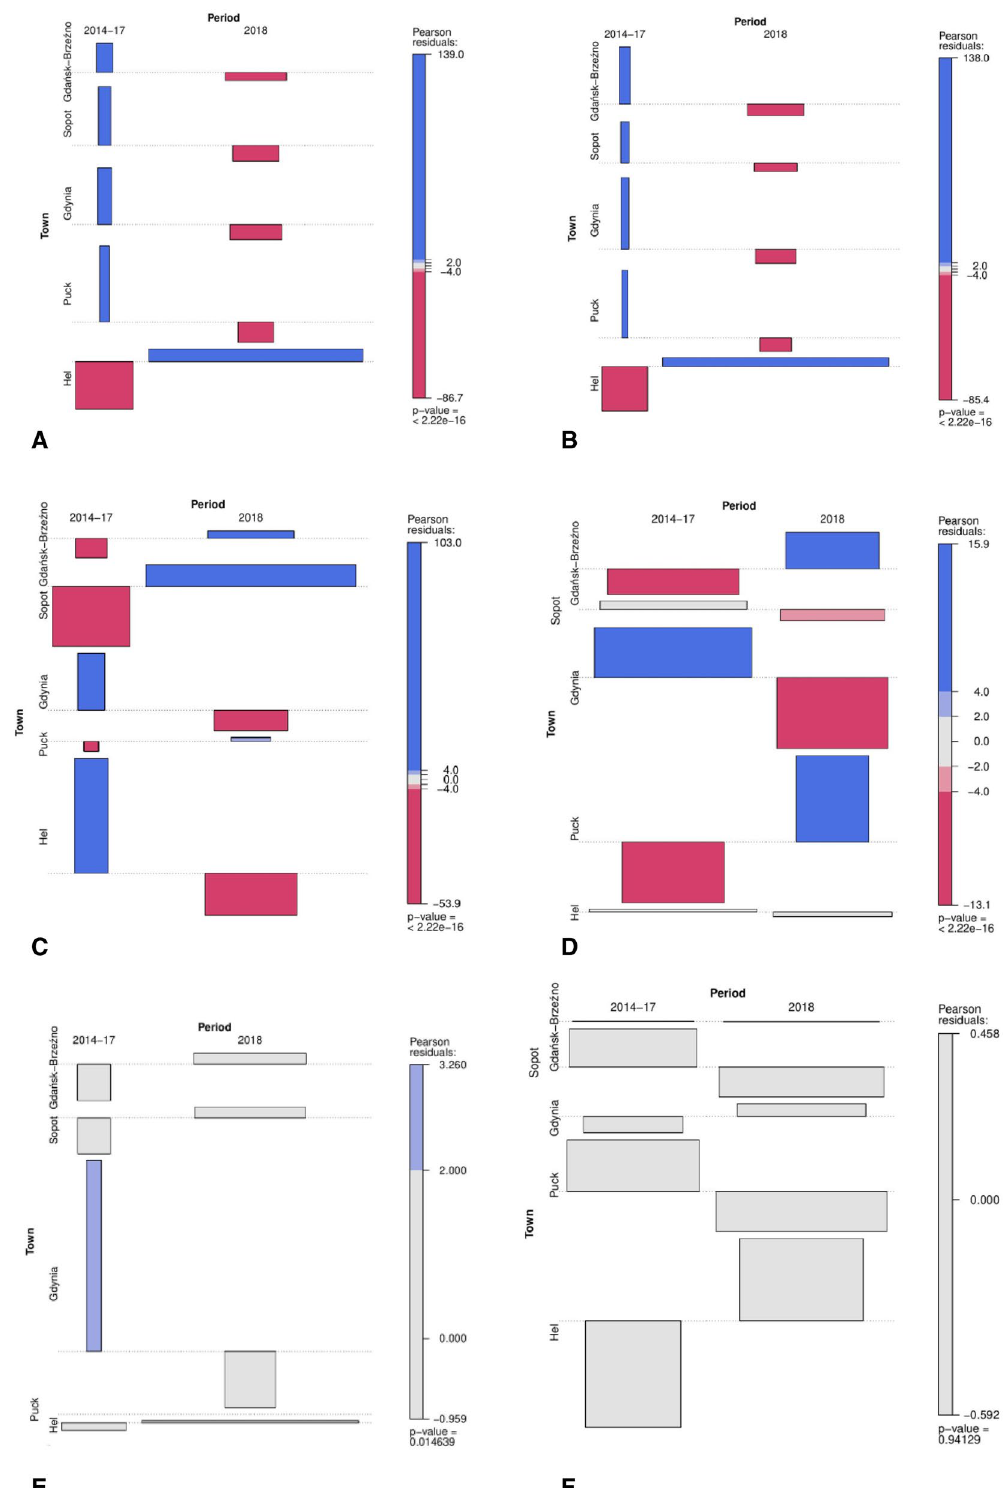
Figure 1. The association of the contingency table with the mean quantity of psychrophilic ( A ) and mesophilic bacteria ( B ), coliform ( C ) and E. coli ( D ) bacteria, P. aeruginosa ( E ) and S.aureus ( F ) bacteria detected in the SSA samples collected from the Bay of Gdańsk in Hel, Puck, Gdynia, Sopot and Gdańsk-Brzeźno and the time period for the sample collection (2014–2017 and 2018). The blue colour indicates that the observed value is higher than expected if the data was random. The red colour specifies that the observed value is expected value and the grey colour indicates that the observed value is close to the